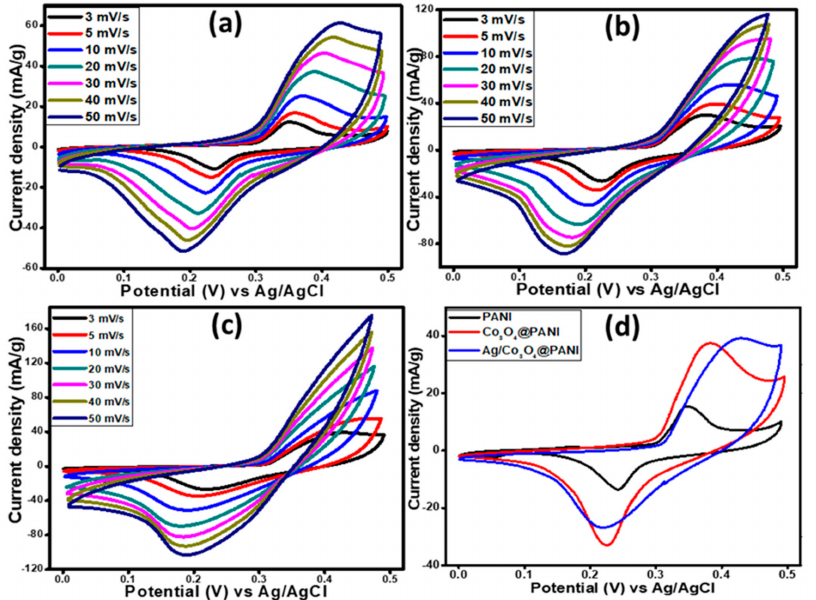
Figure 7. Cyclic voltammograms (CVs) of ( a ) PANI, ( b ) Co 3 O 4 @PANI binary, and ( c ) Ag / Co 3 O 4 @PANI ternary nanocomposites recorded at di ff erent scan rates, and ( d ) comparison CVs of PANI, Co 3 O 4 @PANI binary, and Ag / Co 3 O 4 @PANI ternary nanocomposites recorded at a low scan rate (3 mV s − 1